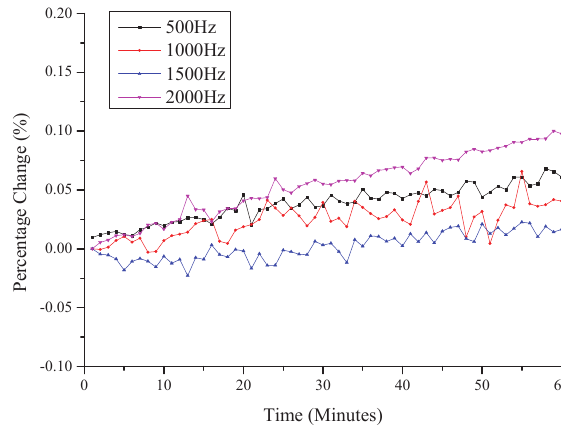
Fig. 2: Output impedance of current source. Measured using HP43284A Impedance Analyser. Fig. 3: Stability of current source over time, measured on a resistor phantom. The slight drift over time is thought be caused by device